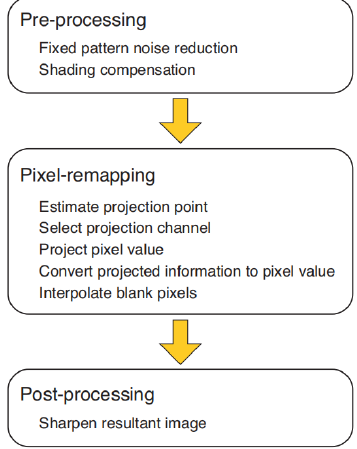
Figure 14. Flow of the reconstruction processing.